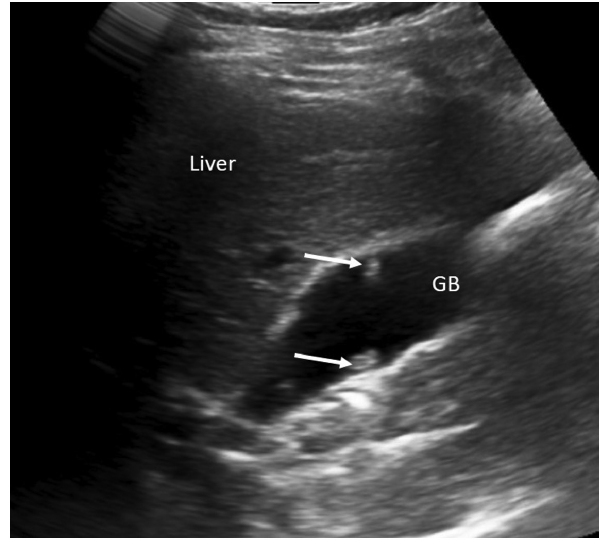
Figure 2. Longitudinal abdominal US of the gallbladder (case number 14) with multiple echogenic polyps with various diameters (arrows) in the gallbladder. GB, gallbladder; US,